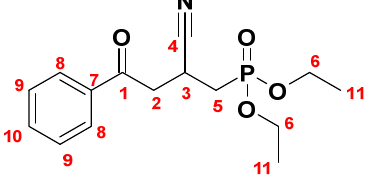
Figure 2. The structure of compound 5b .